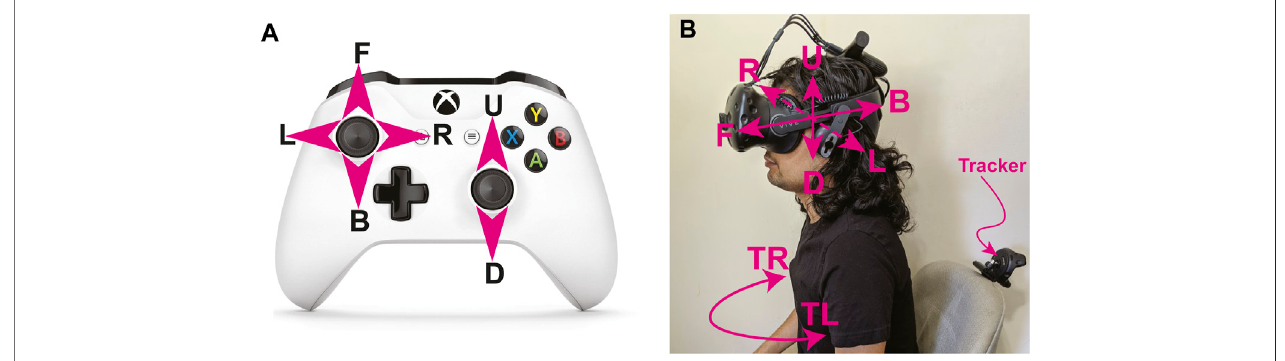
FIGURE 2 | (A) In Gamepad, the left thumbstick controls the horizontal velocity ( F orward, B ackward, L eft, R ight) and the right thumbstick controls the vertical velocity ( U p, D own) (B) In HeadJoystick, the user ’ s head position controls the velocity. In both cases, physical rotation ( T urning R ight, T urning L eft) is